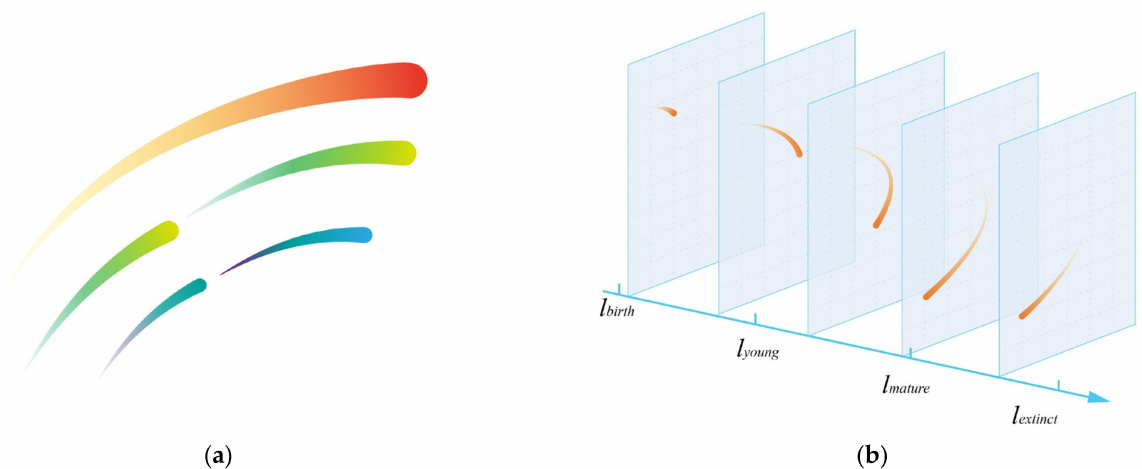
Figure 5. ( a ) The head-to-tail asymmetry along the streamline can clearly provide direction and orientation signals, it can be accomplished by shape and transparency; the color and step size of primitive can indicate magnitude. ( b ) Particle dynamic rendering diagram with continuously updated